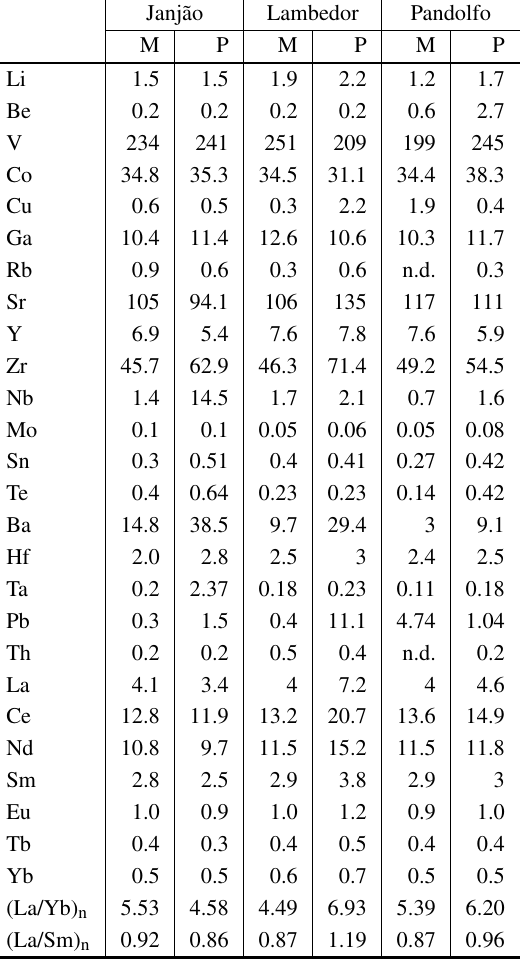
Trace elements and REE contents of clinopyroxenes. P, clinopyroxene from peridotite; M, clinopyroxene from megacrysts; n.d., not detected.